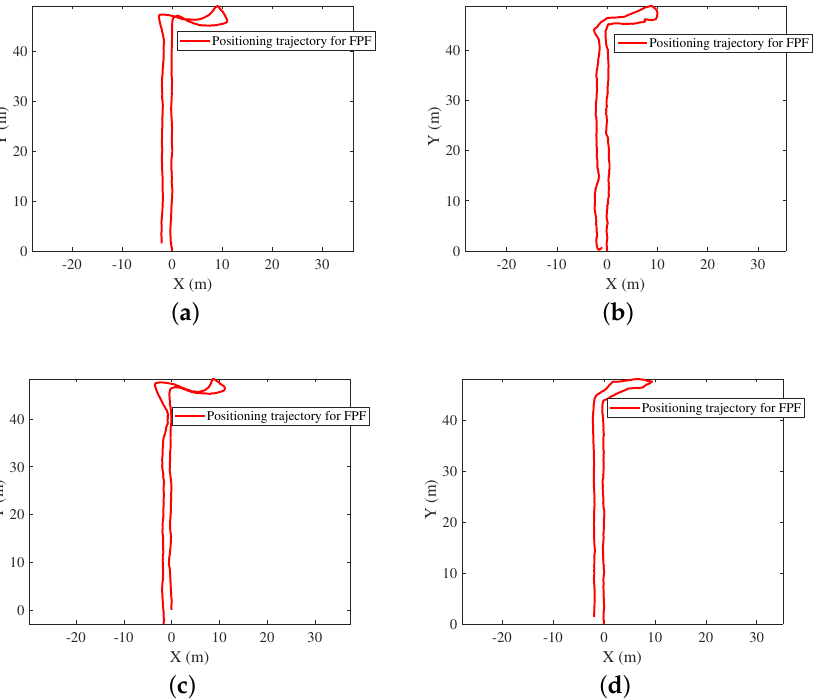
Figure 12. Navigation trajectories for FPF. ( a ) Calling mode. ( b ) Dangling mode. ( c ) Handheld mode. ( d ) pocketed